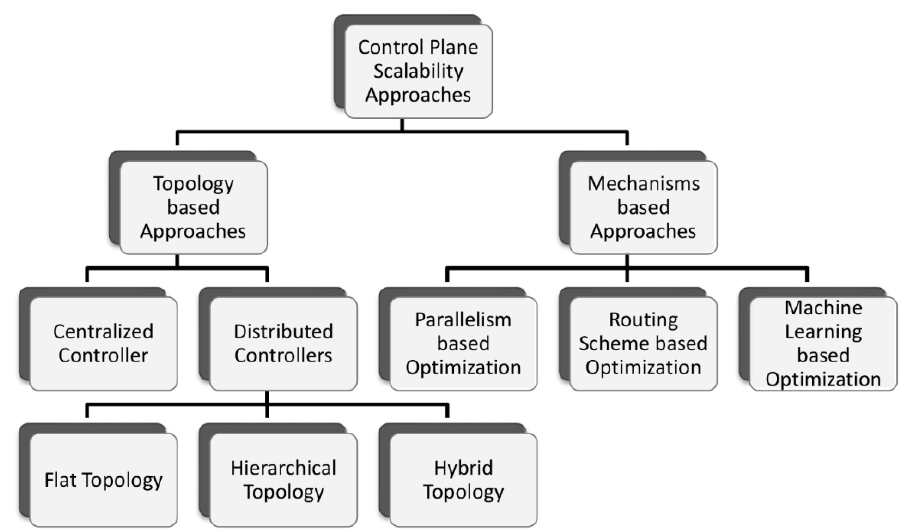
Figure 2. Classification of Control Plane Scalability Approaches .